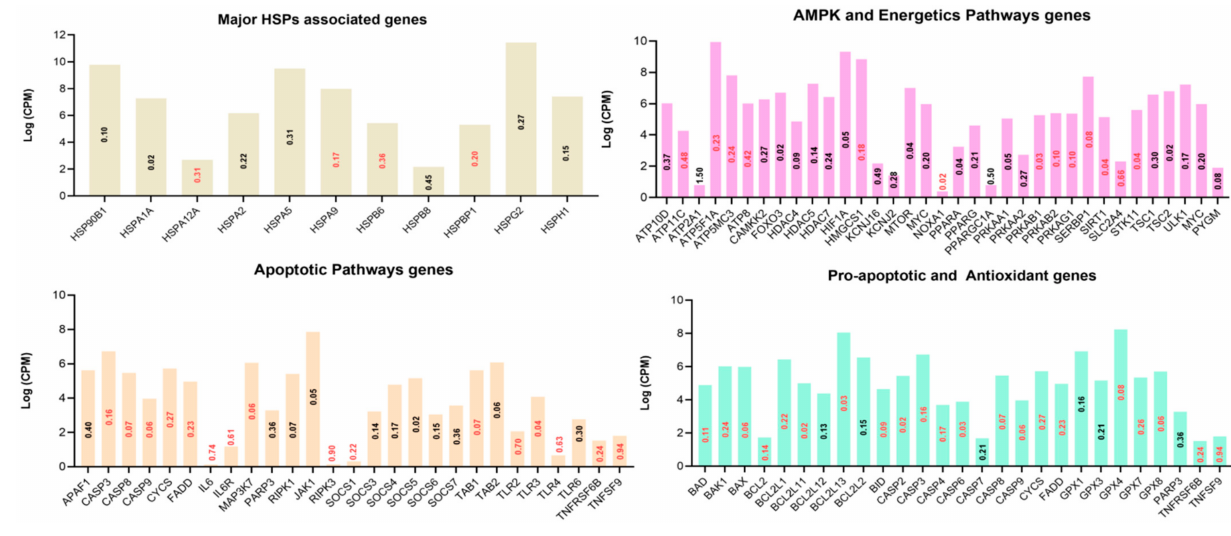
Figure 4. Bar charts based on the manual querying of the differentially expressed genes. Various anti-apoptotic, antioxidant, inflammation, cell damage, chaperone, and cellular-energetic-support- associated genes are given. The y-axis represents the log of counts per million and the log of fold change is presented inside the bars (red upregulated and black downregulated) against respective genes on the x-axis.